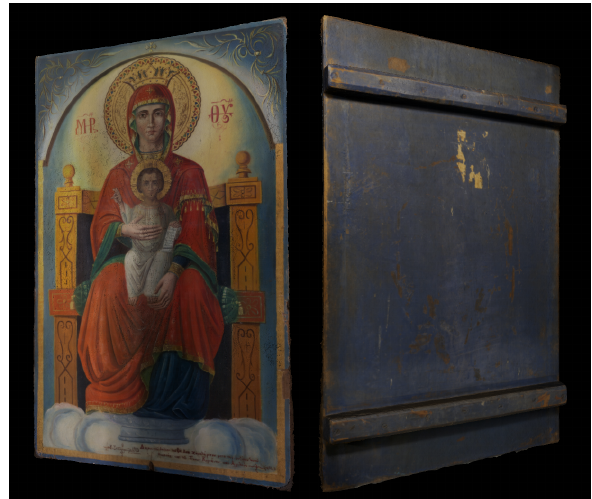
Figure 2: Current Icon in Asinou, 19th Century